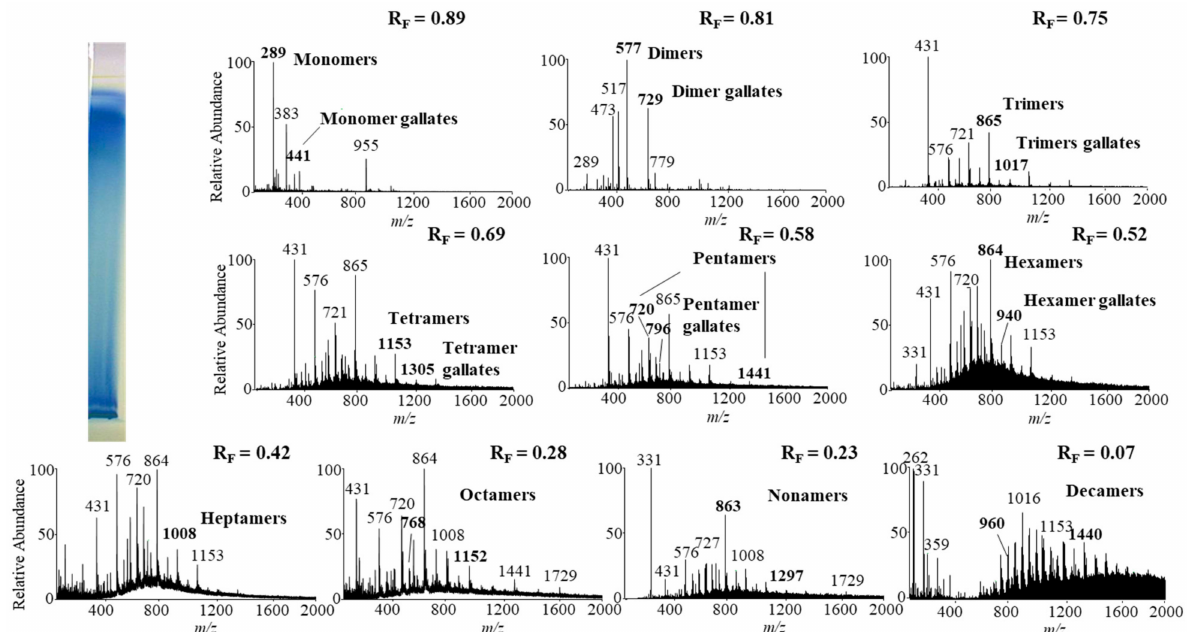
Figure 9. The MS spectra obtained by HPTLC–MS analysis of STS from giant knotweed rhizomes on the HPTLC diol F 254S plate pre-developed and developed with acetonitrile. The bolded m/z values in the MS spectra belong to B-type proan thocyanidins and their gallates eluted from the underivatized part of the plate with acetonitrile–methanol (2:1, v/v ). A narrow derivatized (DMACA reagent) part of the plate with blue-colored proanthocyanidins zones was used for the proper positioning of the elution head of the TLC–MS